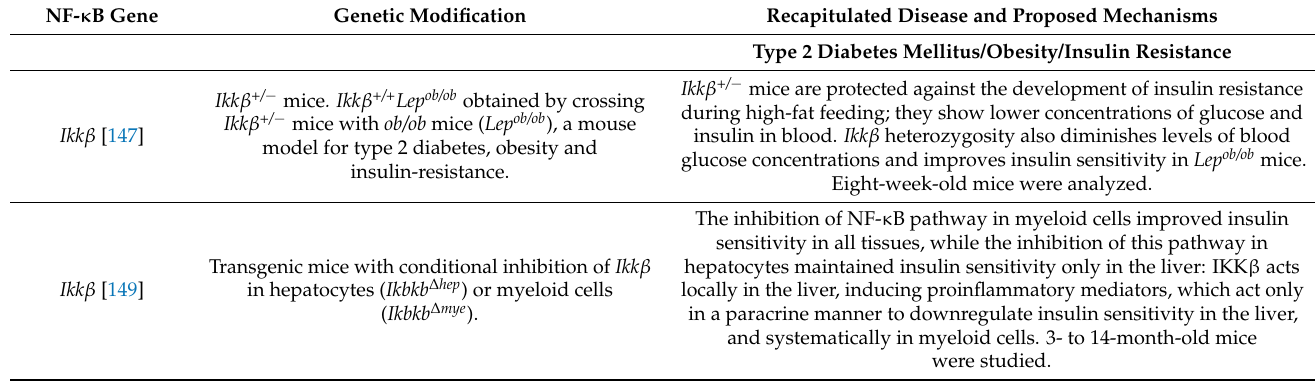
Table 4. Age-related diseases that entail an increased risk of cancer development. Genetic Modification Recapitulated Disease and Proposed Mechanisms Type 2 Diabetes Mellitus/Obesity/Insulin